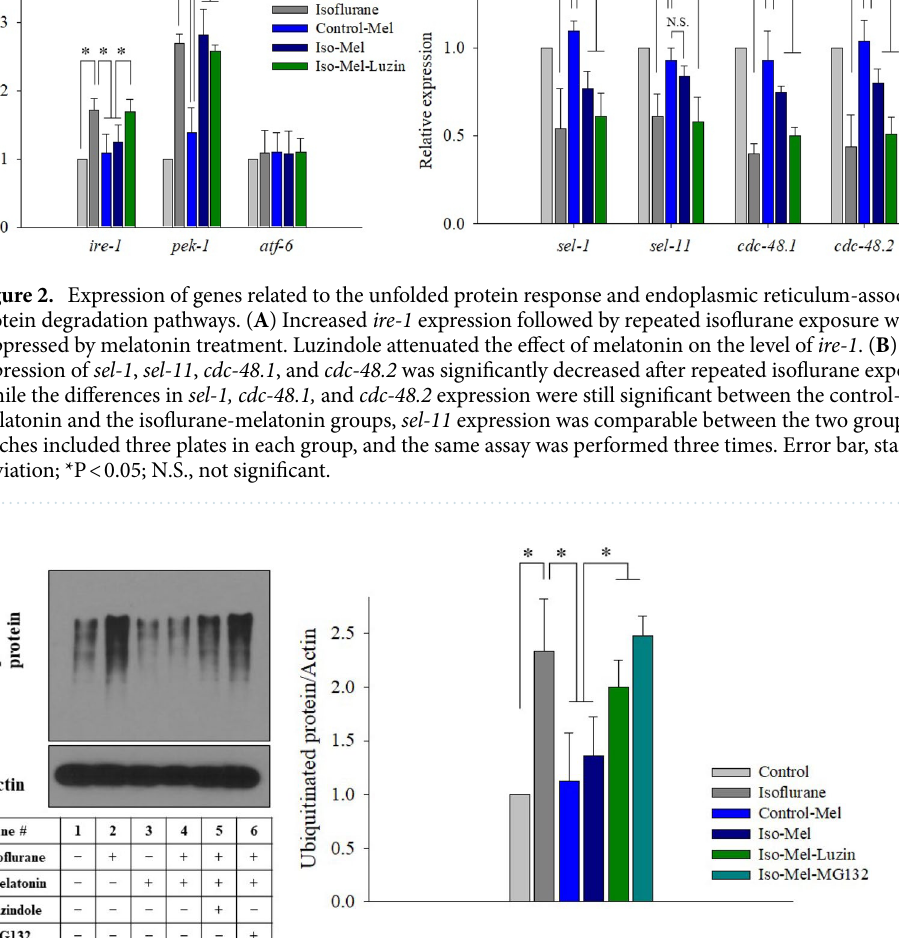
Figure 3. Western blot for ubiquitinated proteins. Higher levels of polyubiquitinated protein were observed in the isoflurane group, which was attenuated by melatonin treatment. The inhibitory effects of melatonin on the accumulation of ubiquitinated proteins were significantly suppressed by luzindole and a proteasome inhibitor, MG132. All batches included three plates in each group and the same assay was performed five times. Error bar, standard deviation. *P <